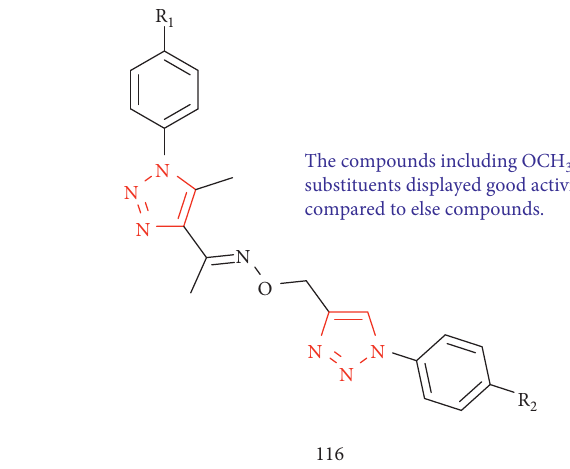
Figure 55: Chemical structure of some new 1,2,3-triazole